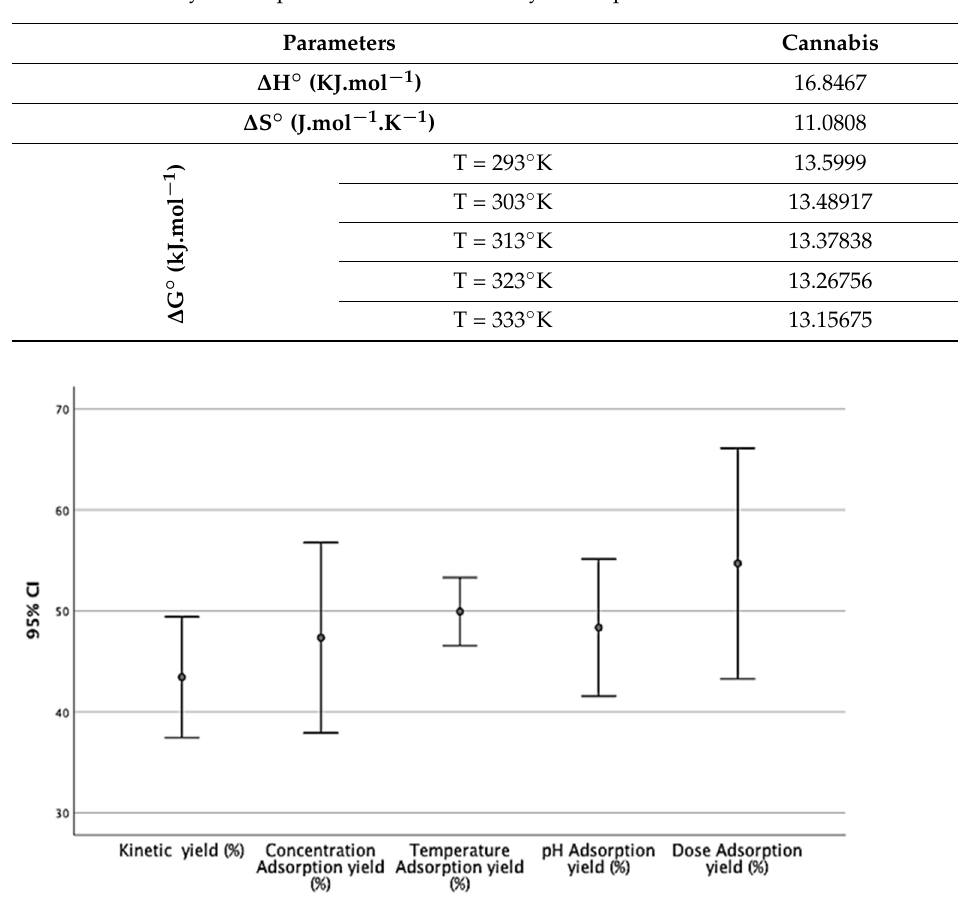
Figure 15 . The 95% confidence intervals for the main analysis of influential adsorption